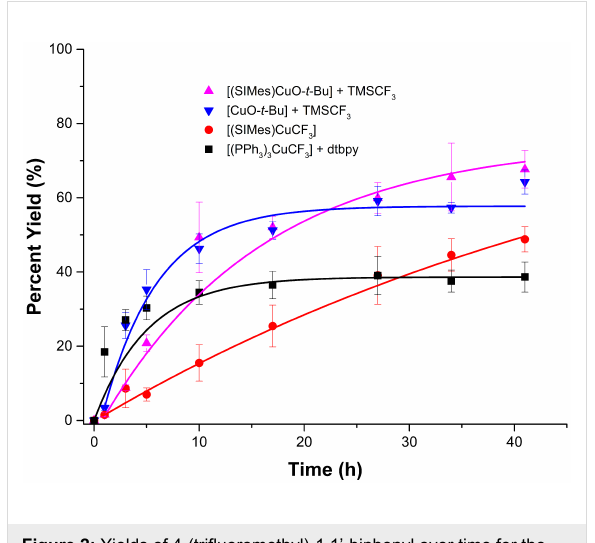
Figure 2: Yields of 4-(trifluoromethyl)-1,1’-biphenyl over time for the systems described in Scheme 1. Conditions for C1 : [(PPh 3 ) 3 Cu(CF 3 )] + dtbpy: toluene, 80 °C. Conditions for A1 : [(SIMes)Cu(CF 3 )] and A2 ([(SIMes)Cu(O- t -Bu)] + TMSCF 3 : DMI/benzene (1.5:7.5), 50 °C. DMI = 1,3-dimethyl-2-imidazolidinone. Conditions for B2 : [(Cu(O- t -Bu)] 4 + phen +TMSCF 3 : DMF, 50 °C. Yields were monitored by gas chromatography relative to a calibrated internal